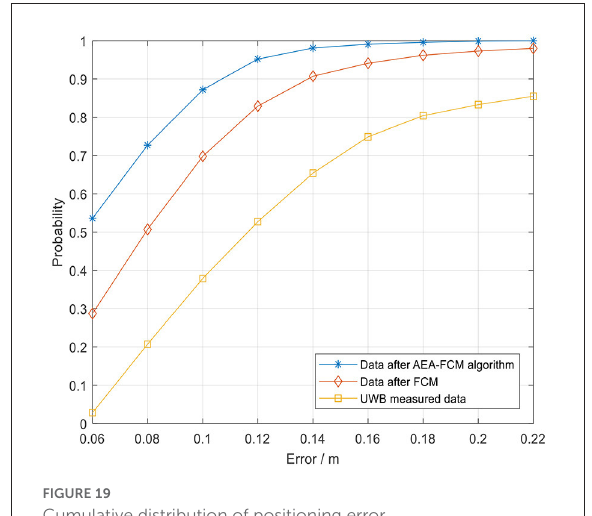
FIGURE19 Cumulative distribution of positioning